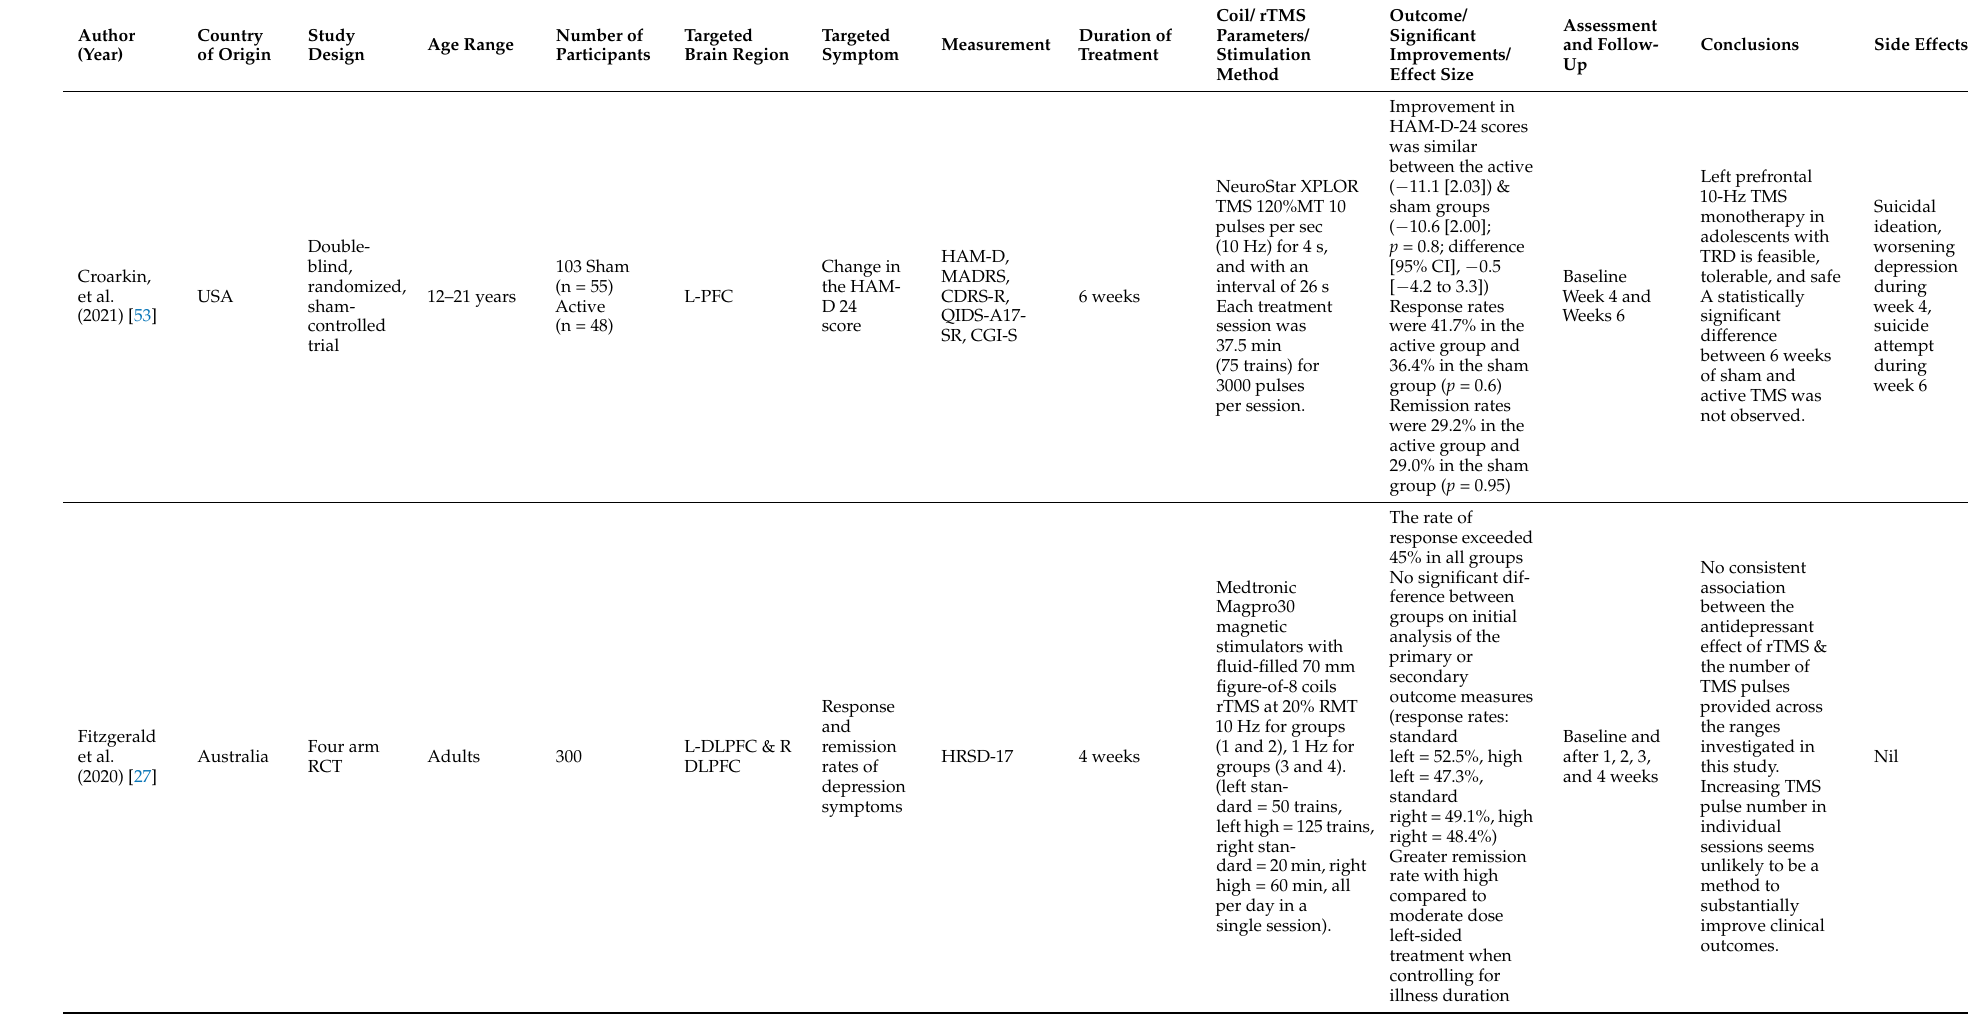
fluid-filled 70 mm figure-of-8 coils rTMS at 20% RMT 10 Hz for groups (1 and 2), 1 Hz for groups (3 and 4). (left stan- dard = 50 trains, lefthigh=125trains, right stan- dard=20min,right high = 60 min, all per day in a single